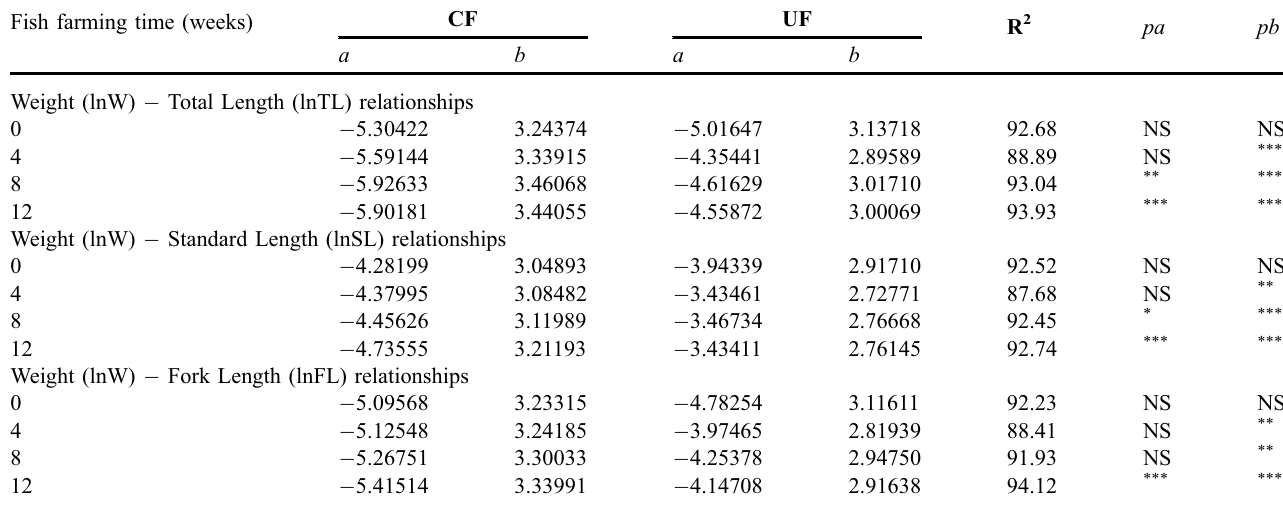
Table 3. Coef fi cients (a: intercept. b: slope) of body weight (g) (cid:1) length (cm) linear regression lines (after ln transformation of data) for CF ( fi sh group in control-RAS) and UF ( fi sh group in Ulva -RAS), adjusted R 2 of the model estimated at different time periods of sea bass farming. Fish farming time (weeks)